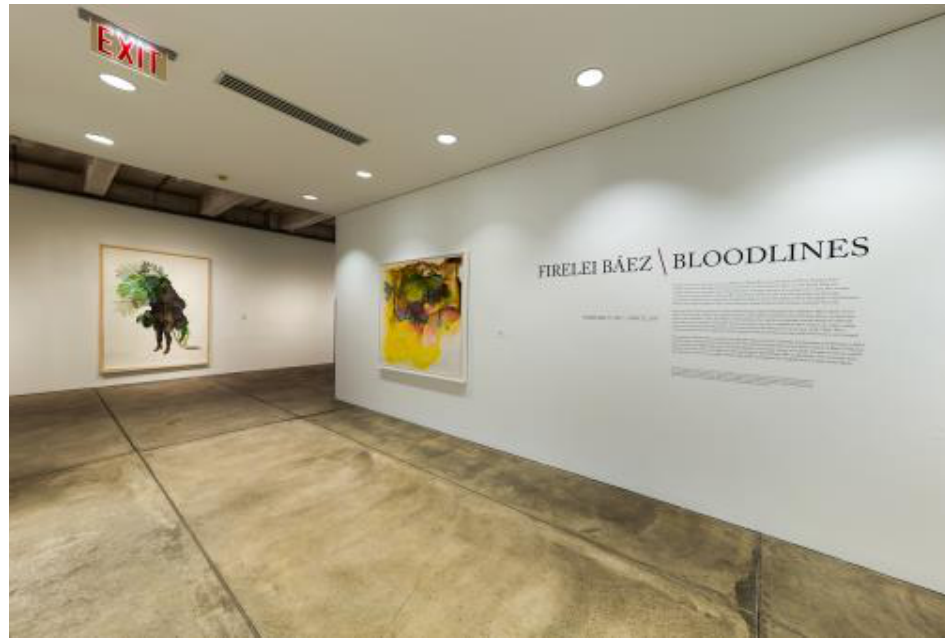
Installation view of Firelei Báez: Bloodlines with (left to right) Ciguapa Pantera (to all the goods and pleasures of this world) (2015, acrylic and ink on paper, 69 x 95 in.) and Body speaking to the space you fill up and keep (2016, acrylic on Yupo paper, 80 × 60 × 4 in. framed), The Andy Warhol Museum, Pittsburgh , photograph by Abby Warhola,